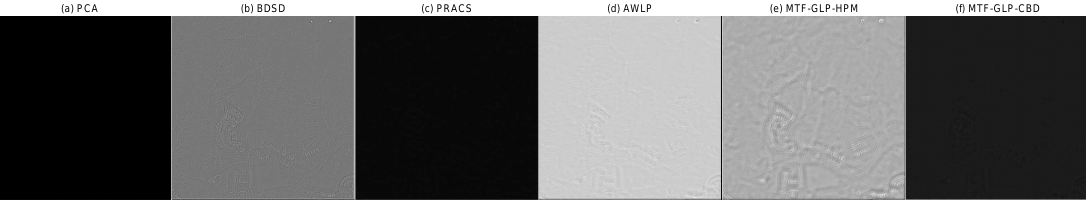
Figure 10. Visualization of weight maps on the QuickBird images, ( a ) PCA; ( b ) BDSD; ( c )